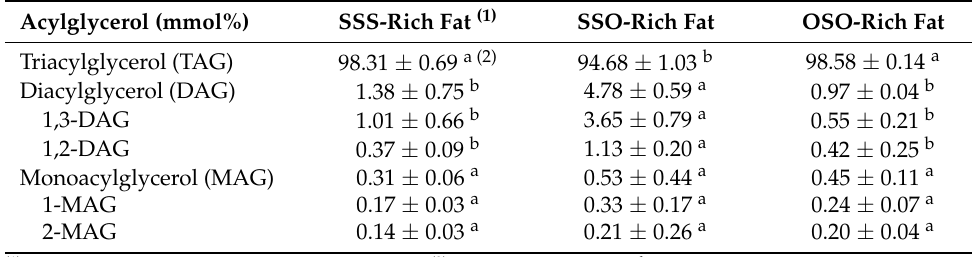
(1) SSS rich fat: Fully hydrogenated soybean oil; (2) Mean ± SD ( n = 2); a,b Means in the same row with different letters are significantly different by Duncan’s multiple range test at p < 0.05. The TAGs in the fats were identified by TAG separation with silver ion-HPLC (Figure 1) and the FA composition determined with GC (Tables 1 and 2). The TAGs were identified as SaSaSa (SSS, PPP, SSP, PSP, PPS, and SPS), SaMoSa (SOS, POS, and POP), SaSaMo (SSO, PPO, PSO, and SPO), SaDSa (SLS, PLP, and SLP), SaSaD/SaMoMo (SSL, PPL, PSL, SPL/SOO, and POO), MoSaMo (OSO and OPO), SaDMo/SaMoD (SLO, PLO/SOL, and POL), MoSaD (OSL and OPL), and MoMoMo (OOO; Table 4). The SSS-rich fat consisted mainly of SaSaSa, the major TAG being SSS. The SSO-rich fat consisted of TAGs in SaSaMo (major TAG: SSO, 86.98%) and MoSaMo (major TAG: OSO, 9.21%), whereas the OSO-rich fat consisted of TAGs in MoSaMo (major TAG: OSO, 67.17%), SaSaMo (major TAG: SSO, 17.22%), and SaSaD/SaMoMo